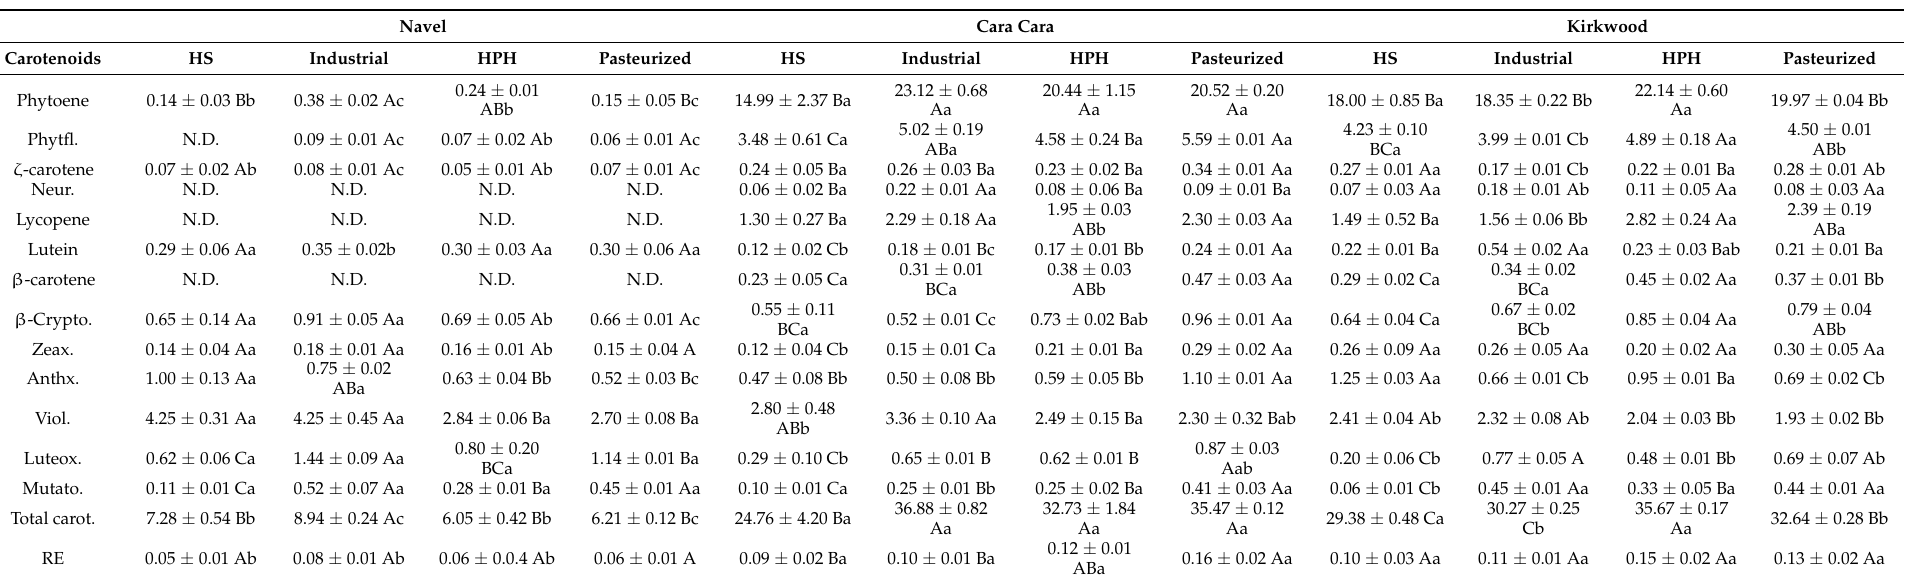
Table 3. Carotenoid content and composition ( µ g/mL) of HS (hand-squeezed), industrial, HPH (high-pressure homogenized), and pasteurized juices of Navel, Cara Cara, and Kirkwood